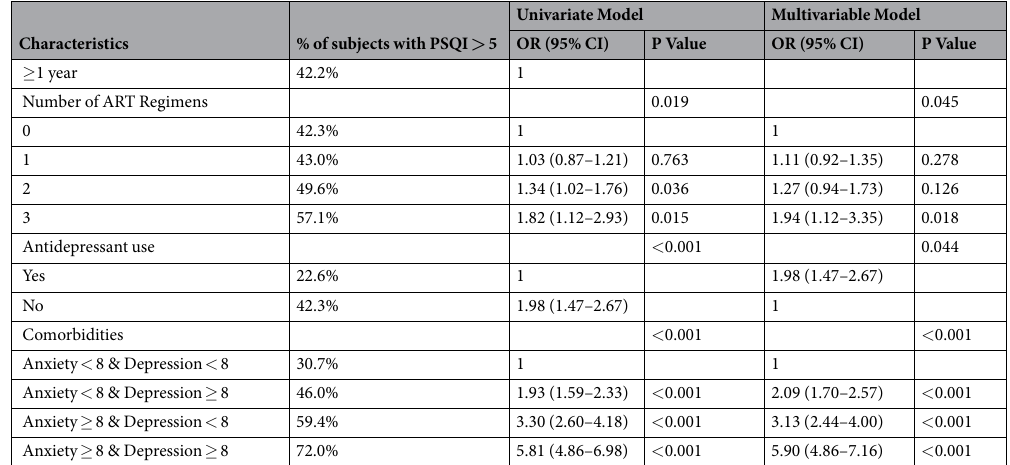
Table 3. Demographic and clinical factors associated with sleep